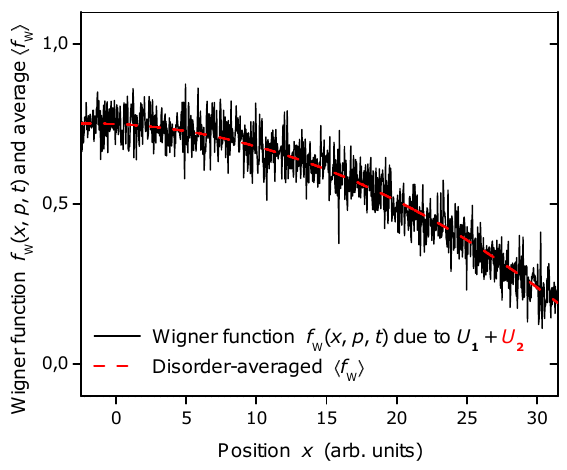
Fig. 6 . Typical position dependence of the Wigner function f ( x , p , t ) in one space dimension x at given p and t . The small- W scale fluctuation of the Wigner function arises from